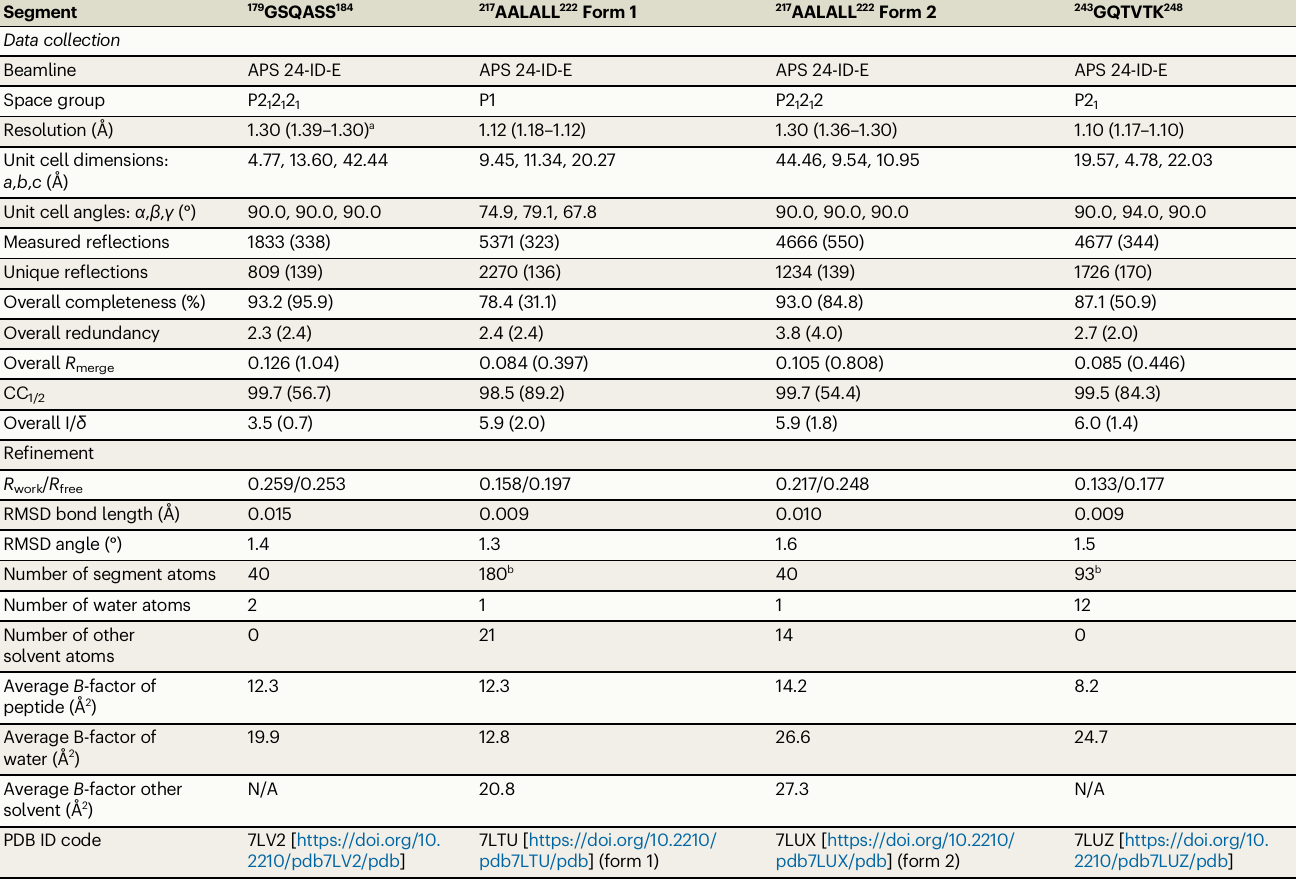
Table 1 | Crystallographic data collection and re fi nement statistics from SARS-CoV-2 NCAP